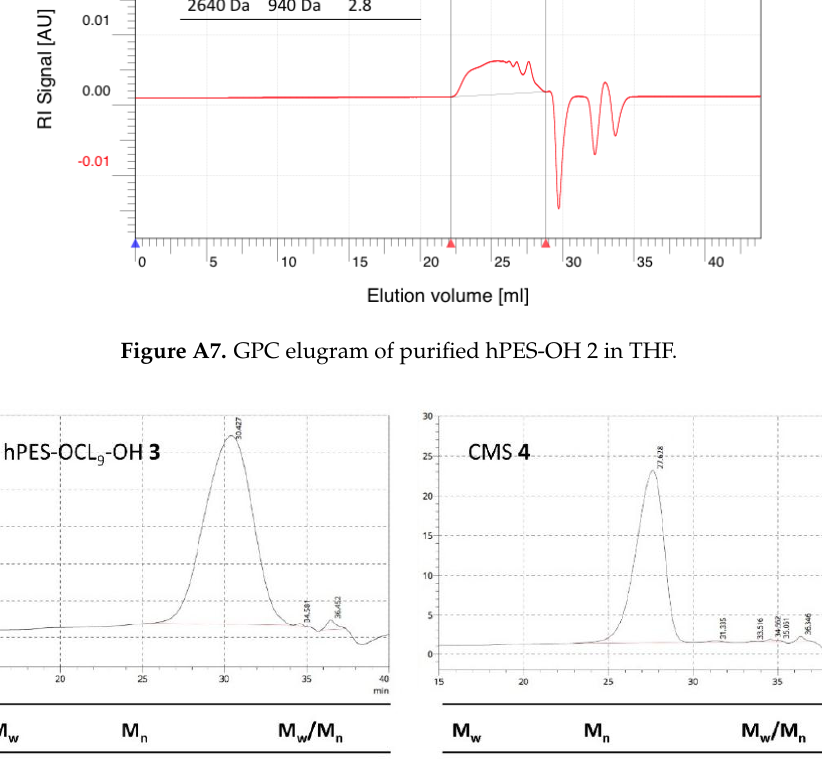
Figure A8. GPC elugram of purified hPES–OCL9–OH 3 and CMS 4 in DMF.